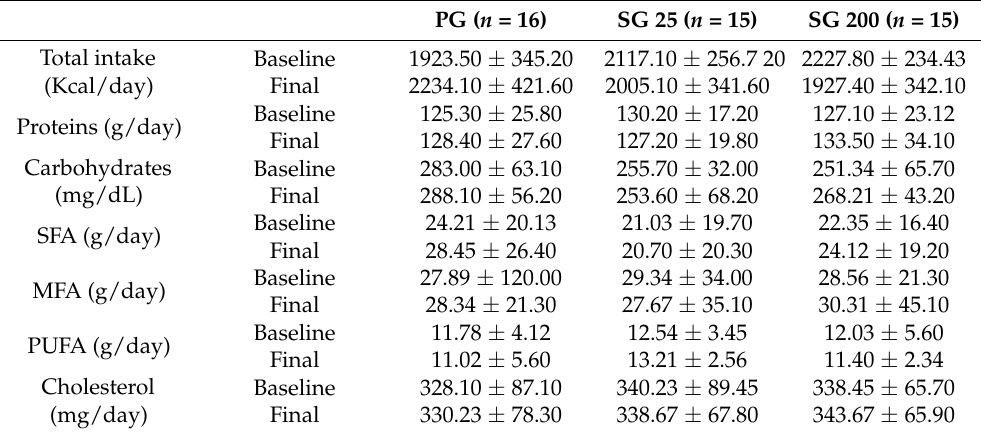
Table 2. Nutritional assessment during the